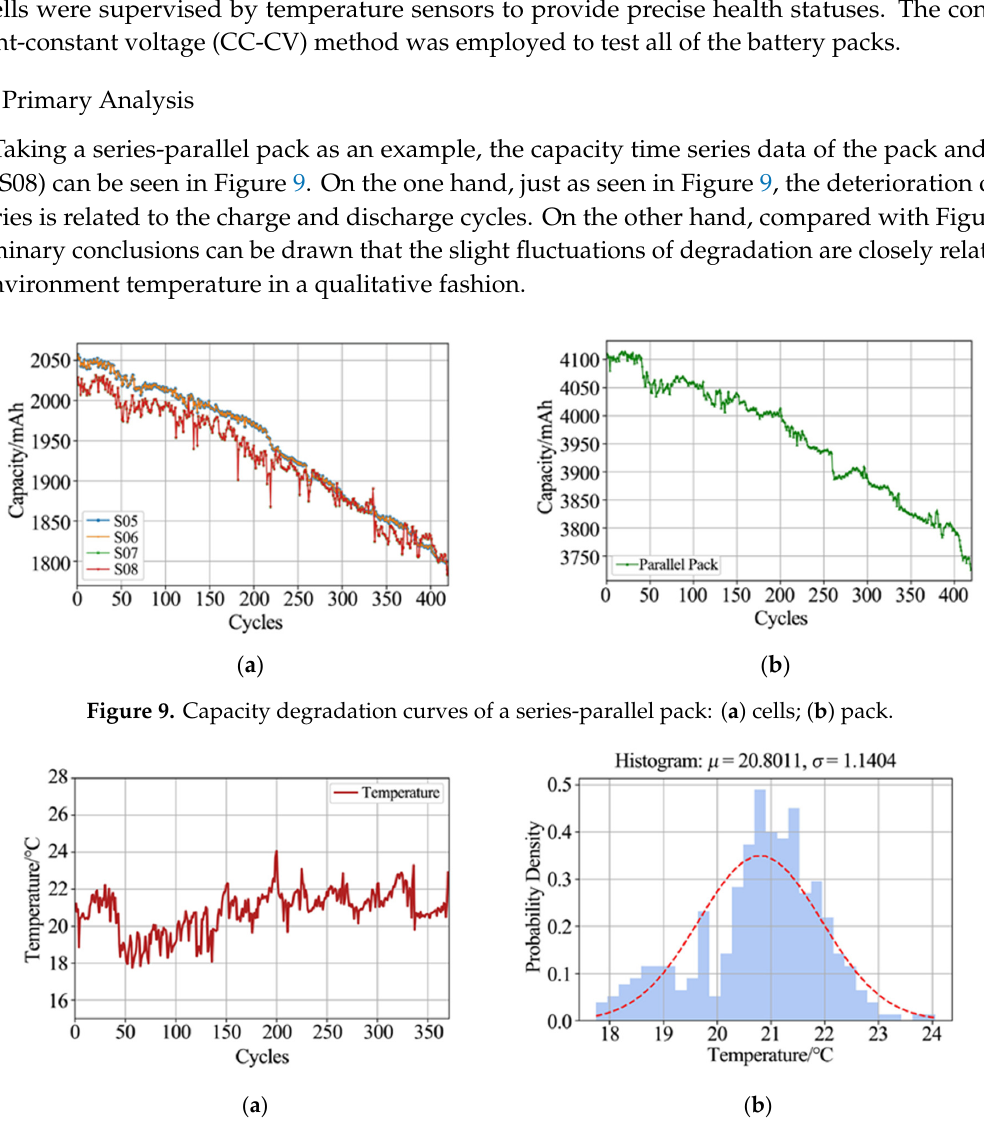
Figure 10. Environment temperature during experiment: ( a ) temperature time series; ( b ) temperature distribution.